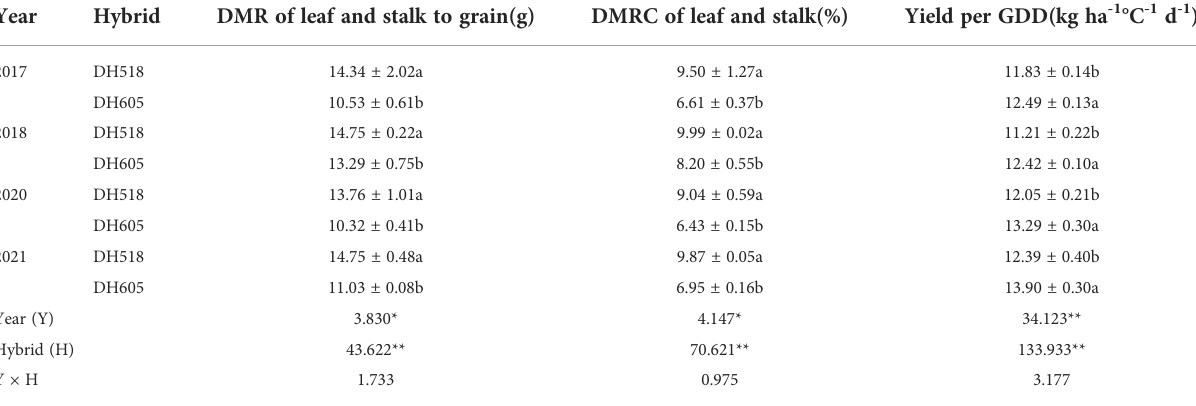
TABLE 4 Contribution to grain dry matter by leaf and stalk dry matter remobilization of summer maize hybrids with different growth duration (2017-2018;